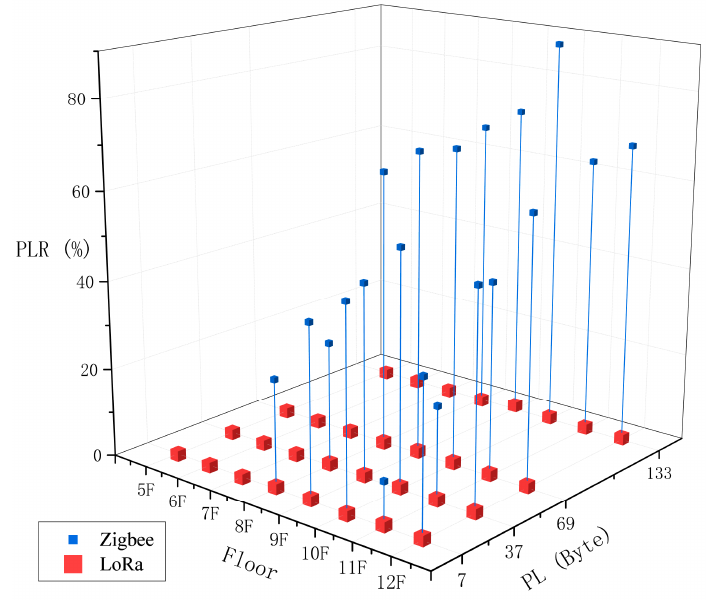
Figure 13. Test results of PLR in window position.